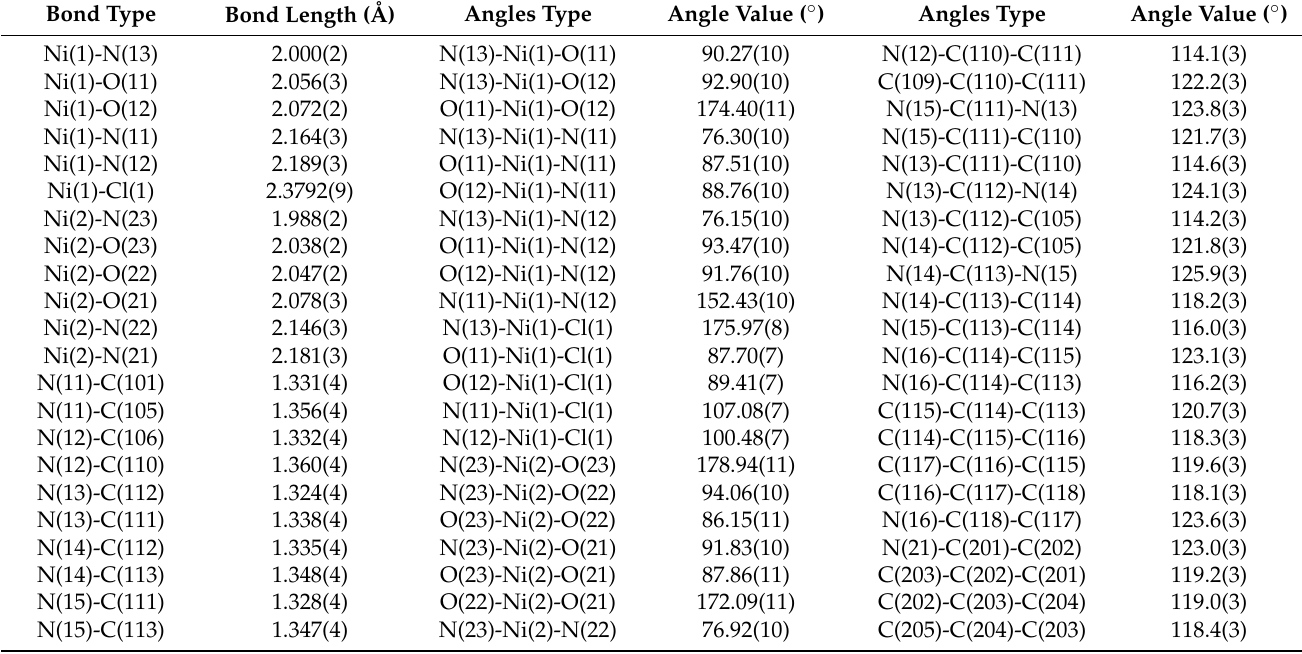
Table 2. Experimental XRD - bonds and angles values.